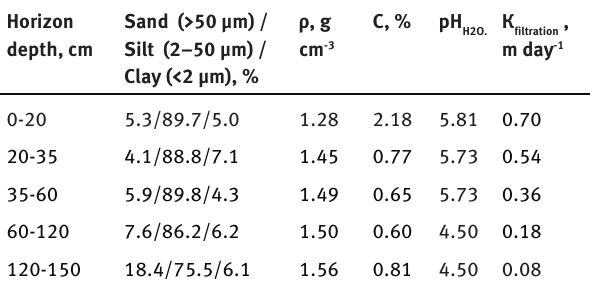
Table 1: Physical, chemical and ecotoxicological properties of cyan-